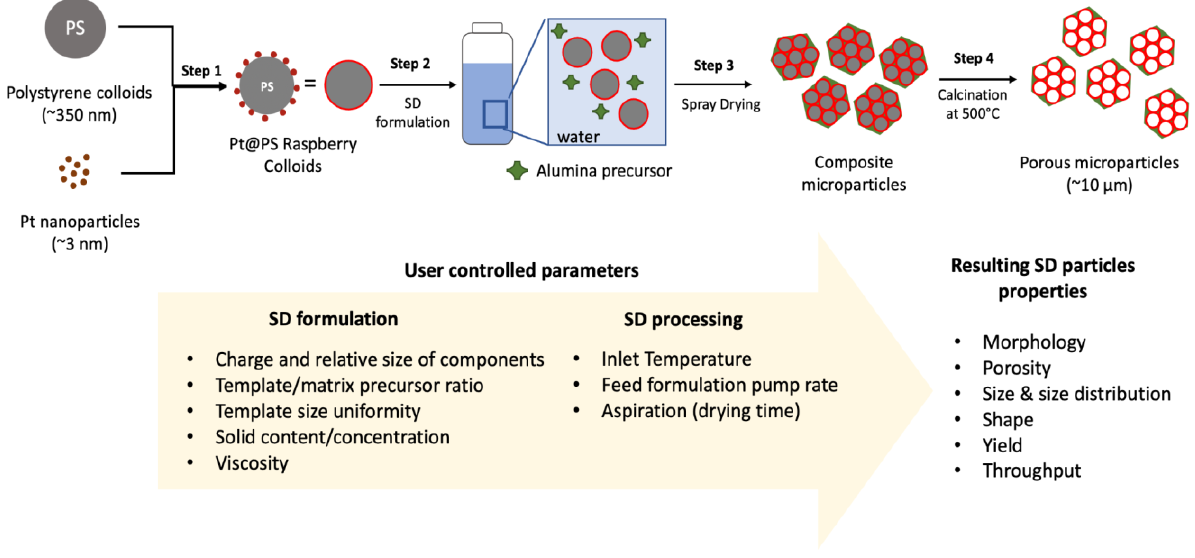
Figure 1. Schematic depicting the process for creating spray-dried (SD) catalytic microparticles using the raspberry colloid templating (RCT) approach.